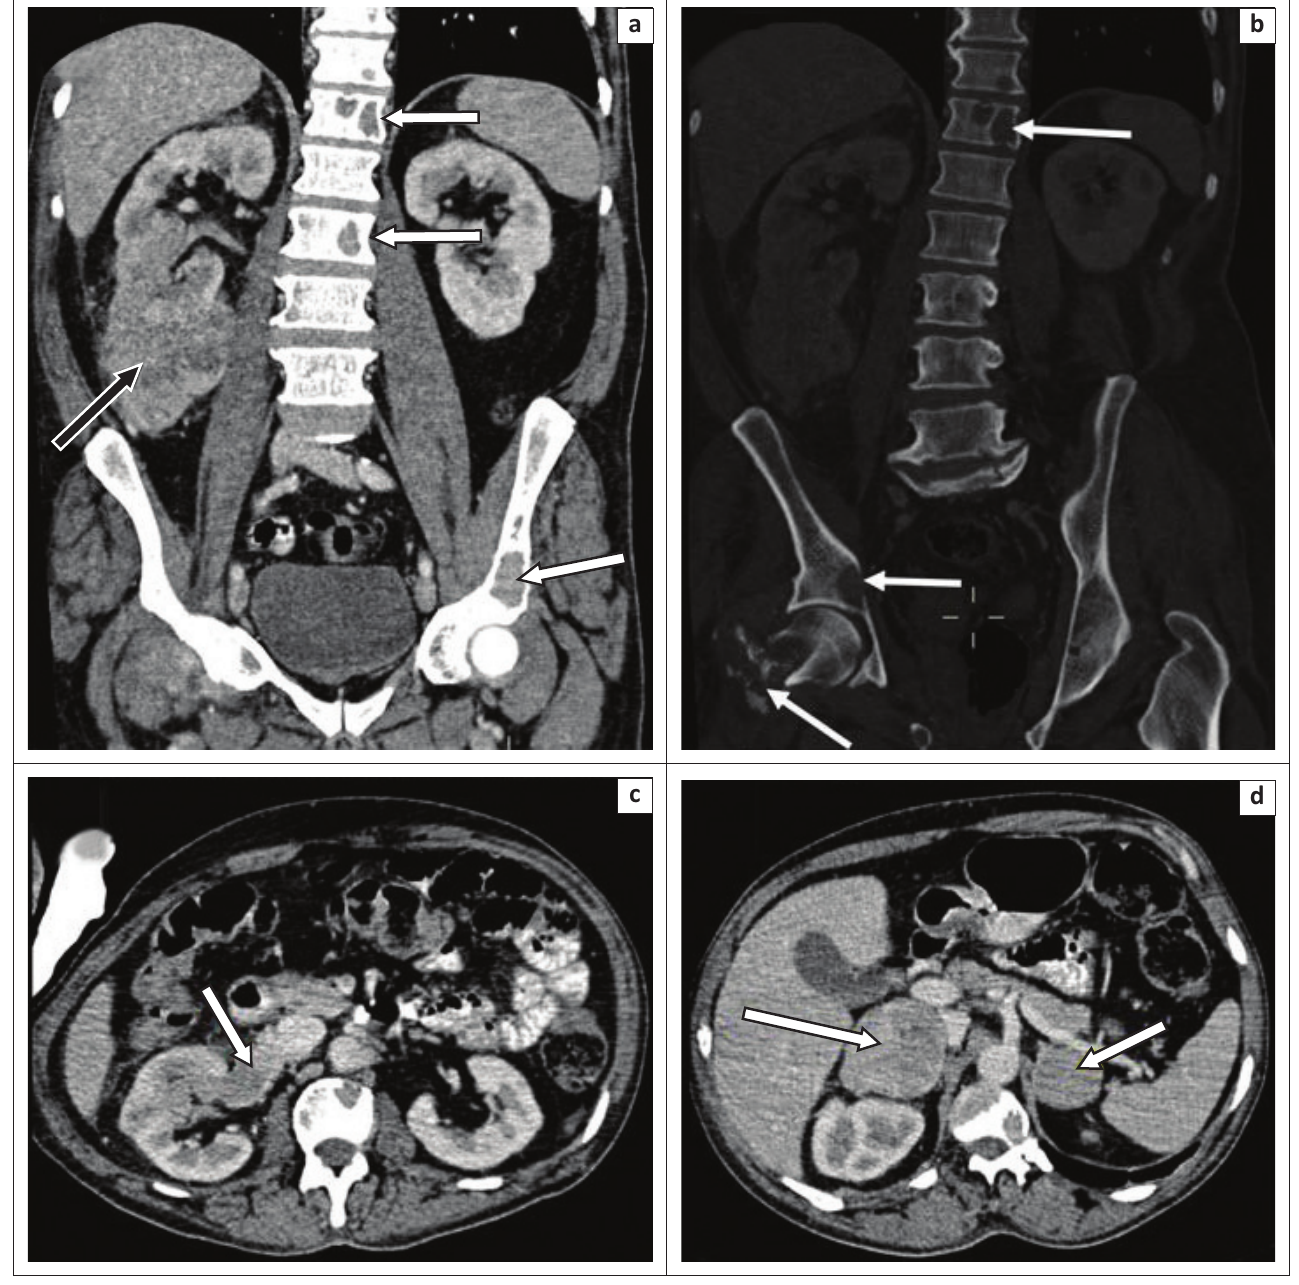
FIGURE 5: Renal cell carcinoma (RCC) in a patient who presented with a pathological right femoral neck fracture. Portovenous phase computed tomography scan coronal images demonstrate (a) a large exophytic heterogeneously enhancing right renal lower pole mass (black arrow) with perinephric fat stranding and thickening of Gerota’s fascia. (a and b) Multiple lytic skeletal metastases in the spine, pelvis and right femur with associated neck of femur fracture (white arrows). (c) An enhancing tumour thrombus in the right renal vein (arrow). There is no extension of the tumour thrombus to the inferior vena cava. (d) Bilateral adrenal gland metastases (arrows) were present. These findings are consistent with stage 4